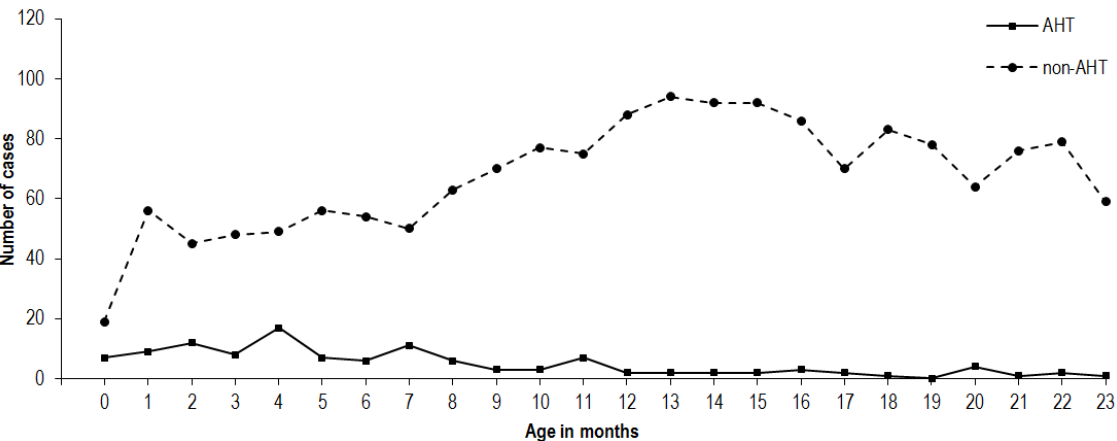
Figure 1. Number of hospitalized children <2 years with suspected AHT and non-AHT by month of age.